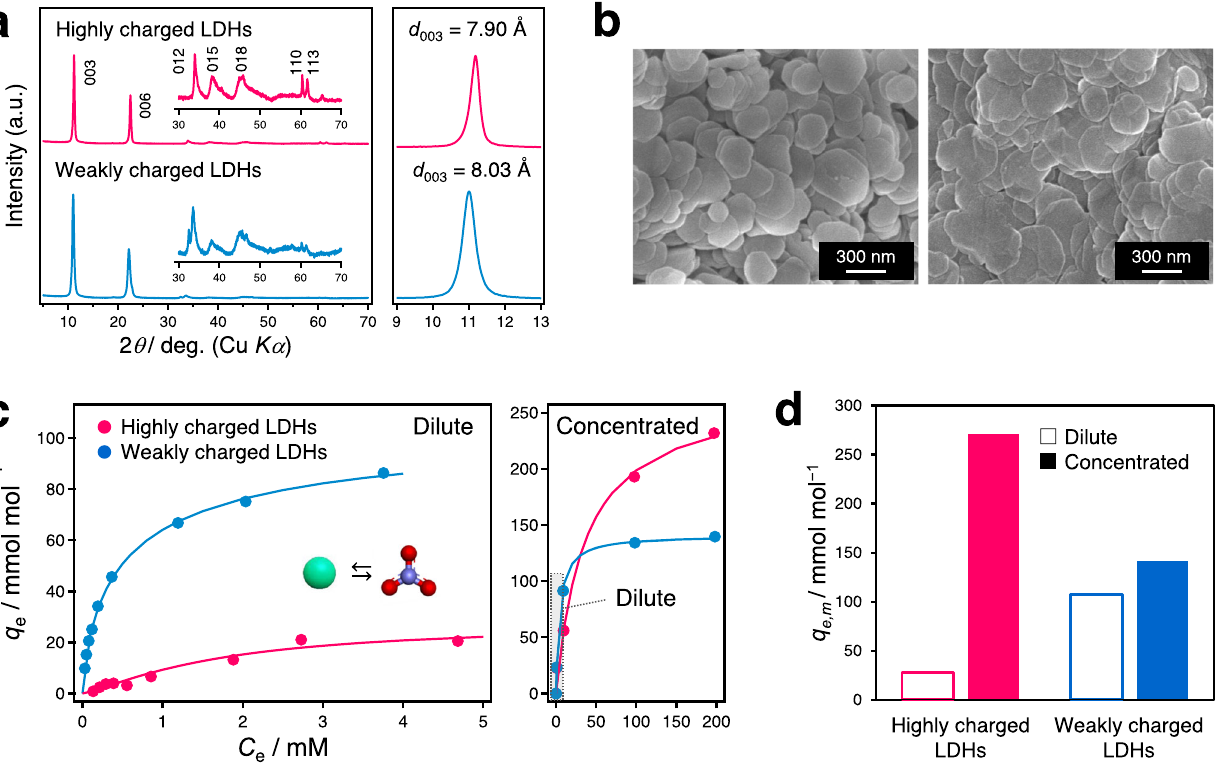
Fig. 2 | Synthesis of LDHs with different charge densities and their ion storage performance for nitrate. a Powder X-ray diffraction (XRD) patterns of the as- prepared Mg/Al LDHs with x =0.28 and 0.22. b Field emission scanning electron microscopy (FE-SEM) of the as-prepared Mg/Al LDHs with x =0.28 (left) and 0.22 (right). c Ion-exchange adsorption isotherms for nitrate with curve- fi t using the